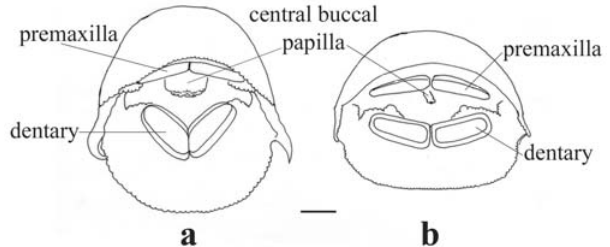
Fig. 9. Ventral view of oral region of Sturisoma sp. (MZUSP 50112, 115.2 mm SL) (a) and Lamontichthys avacanoeiro (MNRJ 18553, 98.1 mm SL, paratype) (b). Scale bar = 2